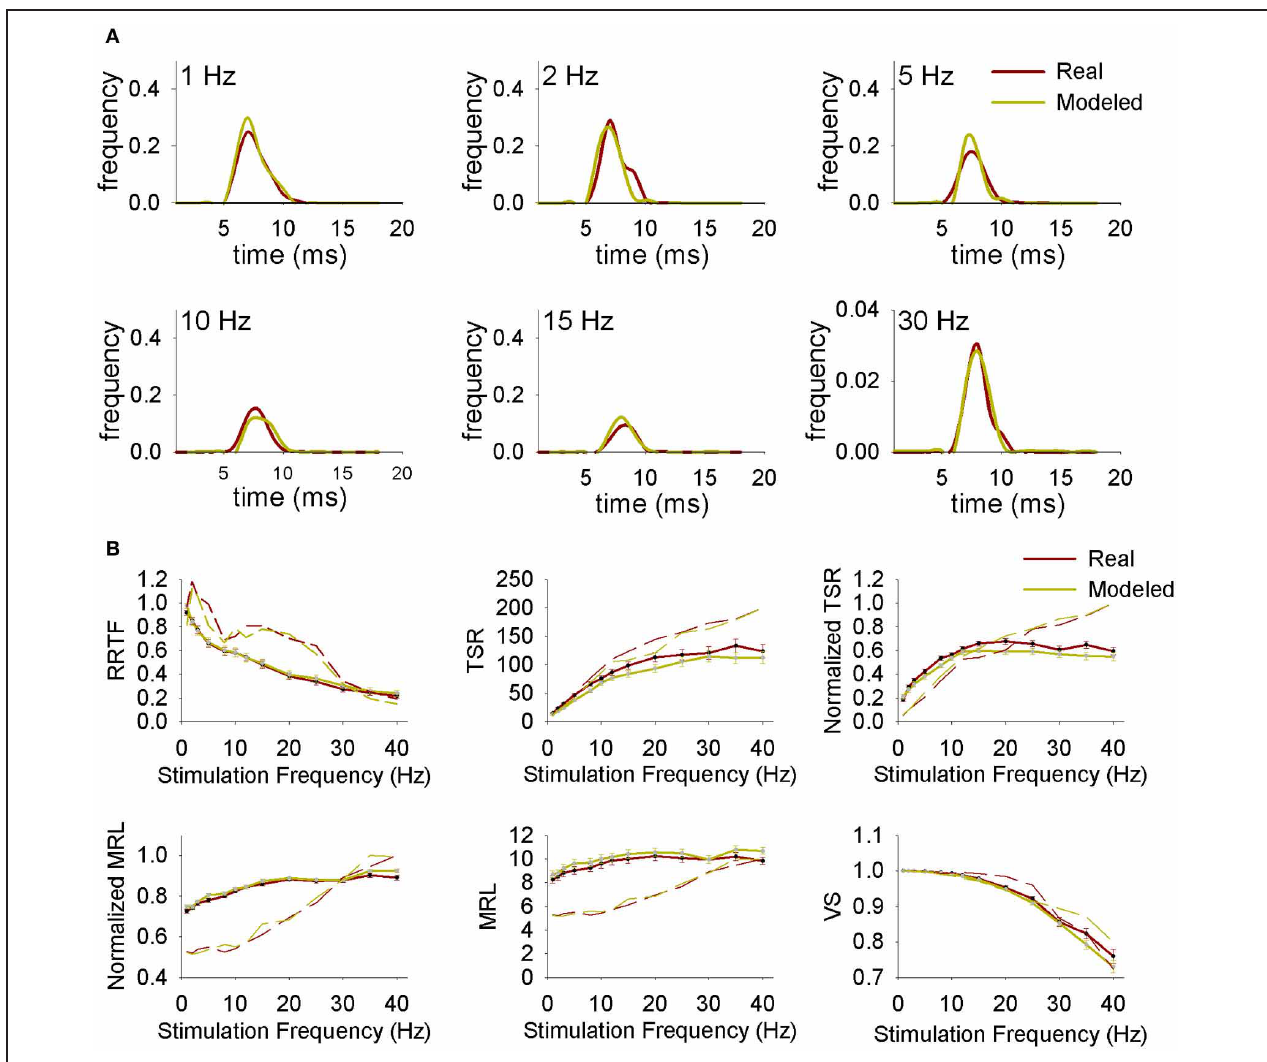
latency (MRL), and vector strength (VS) values at each stimulation frequency from real and modeled neurons. Continuous lines correspond to average values while dashed lines correspond to representative individual